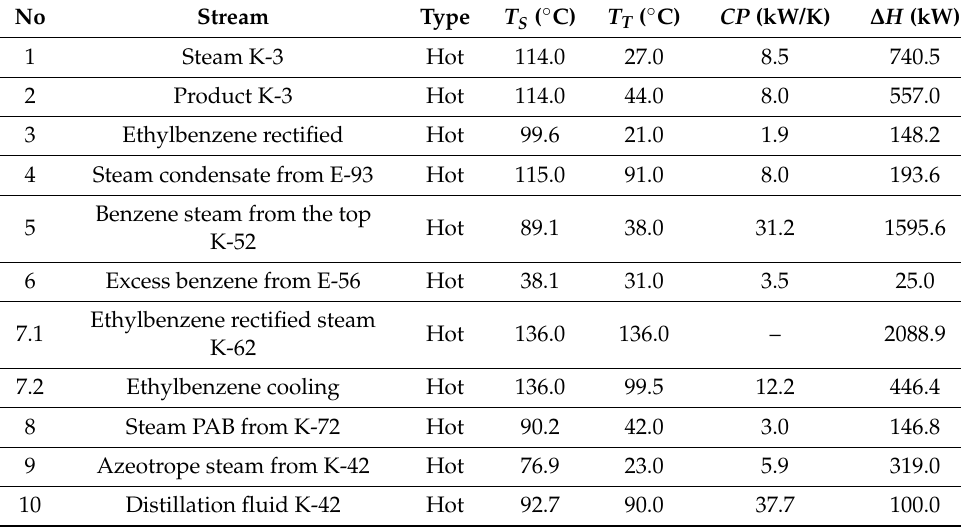
Table 1. Stream data ethylbenzene production